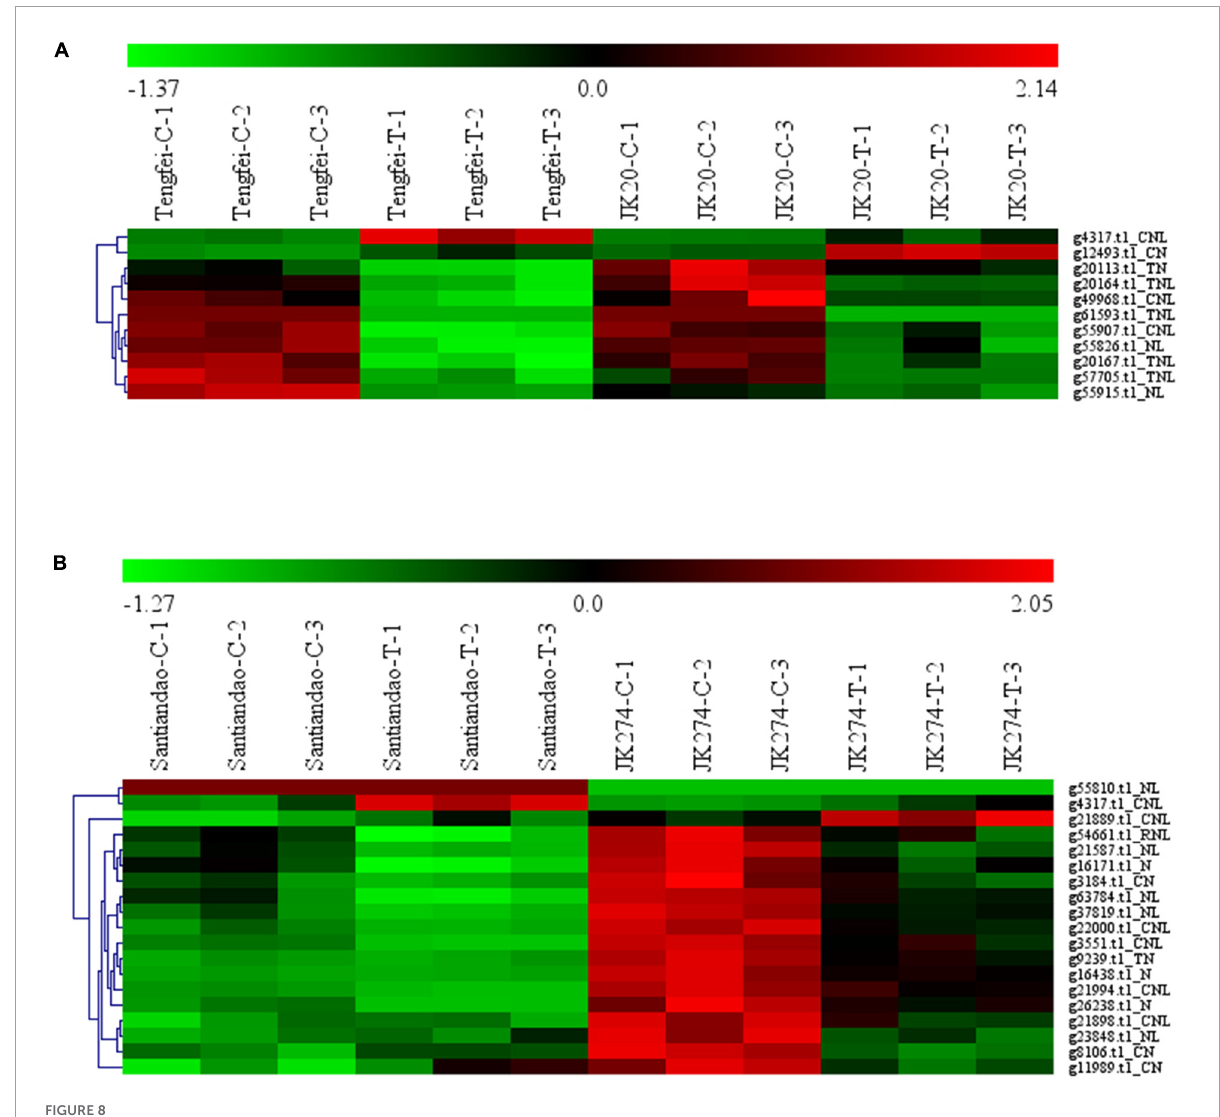
FIGURE8 Heatmap of the expression profiles of differentially expressed genes (DEGs) in response to sweet potato stem nematodes and Ceratocystis fimbriata resistance. (A) DEGs in “Tengfei” and “JK20” under control and sweet potato stem nematodes inoculation. (B) DEGs in “Santiandao” and “JK274” under control and C. fimbriata inoculation. C, control; T,